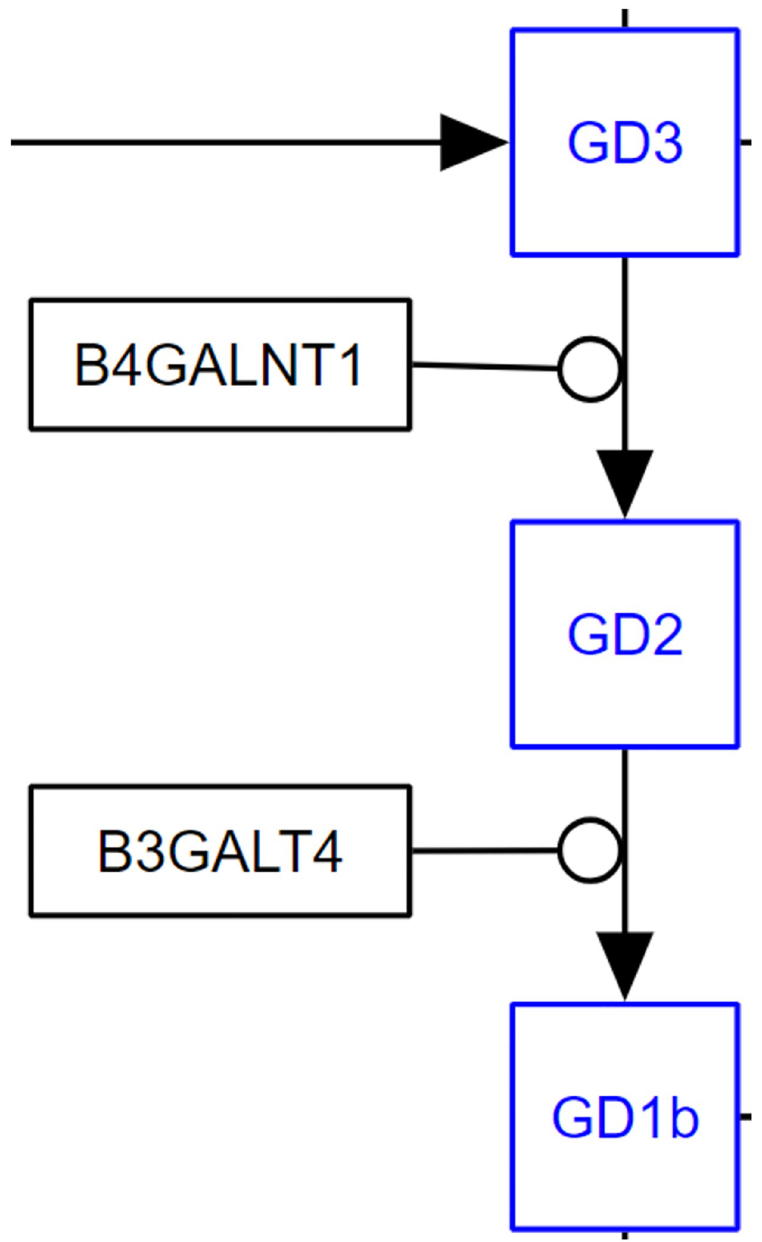
Fig 5. Representation of conversion of different sphingholipids to their products and the relevant enzyme catalyzing the reaction from the Ganglio Sphingolipid Metabolism pathways (wikipathways:WP1423). In this case, GD3 is converted to GD2 by the enzyme B4GALNT1. GD2 is then in turn converted to GD1b and catalyzed by